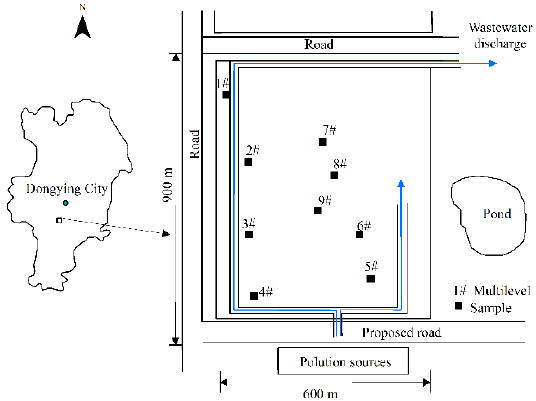
Figure 1. Location of the study site and the preliminary survey bores.